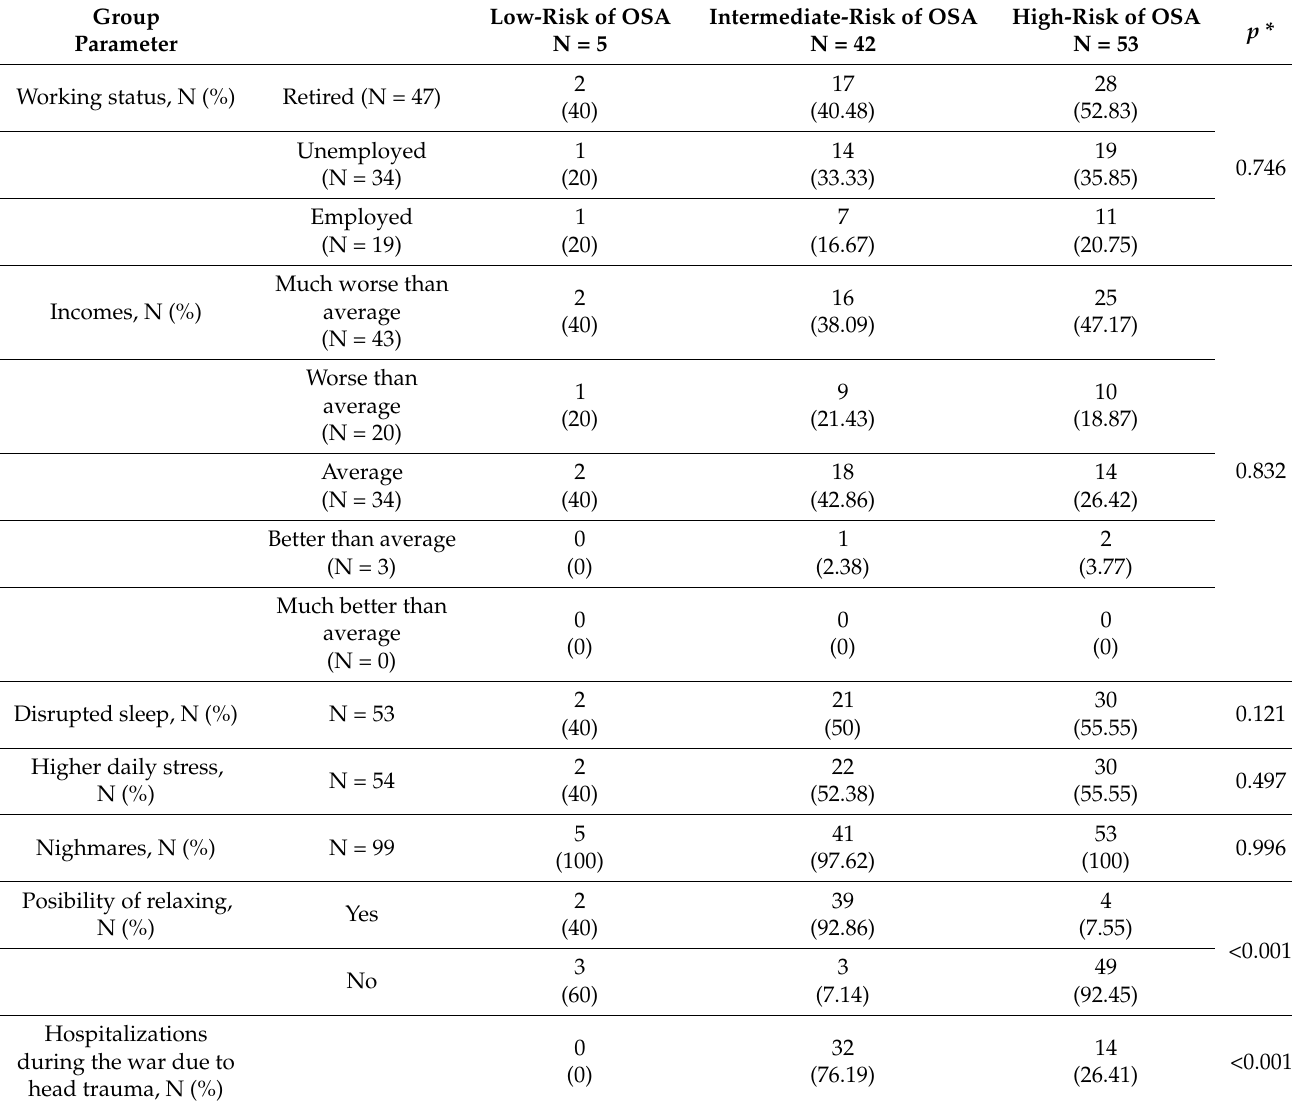
Table 2. Presentation of participants’ attitudes about material status, working status, and quality of sleep according to estimated OSA